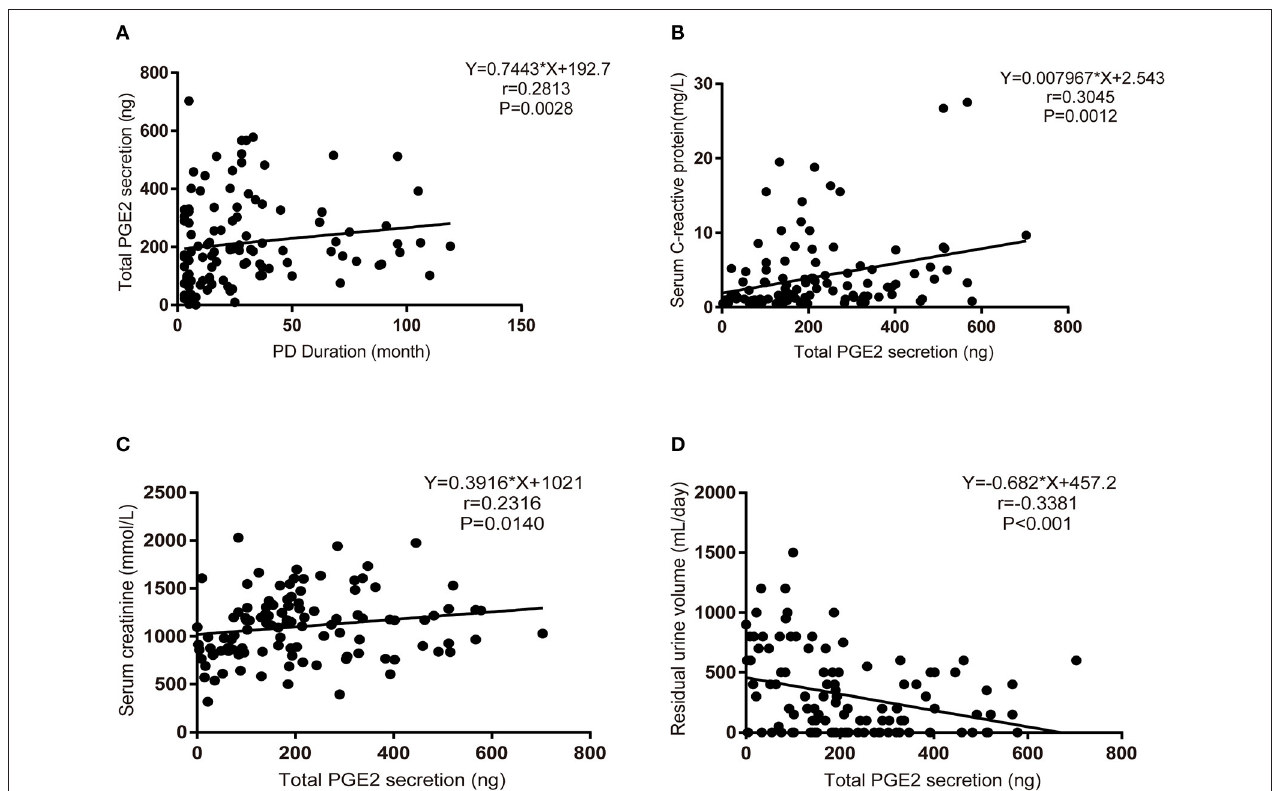
FIGURE 2 | Increased PGE2 secretion during PD therapy. (A) Bivariate correlation analysis between the total secretion of PGE2 and the PD duration in incident PD patients (Spearman’s rank correlation analysis, n = 116). (B) Bivariate correlation analysis between the total secretion of PGE2 and serum C-reactive protein levels in incident PD patients (Spearman’s rank correlation analysis, n = 116). (C) Bivariate correlation analysis between the total secretion of PGE2 and serum creatinine levels in incident PD patients (Spearman’s rank correlation analysis, n = 116). (D) Bivariate correlation analysis between the total secretion of PGE2 and daily residual urine volume levels in incident PD patients (Spearman’s rank correlation analysis, n =